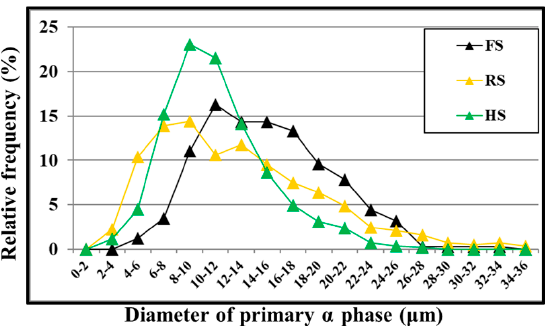
Figure 4. SEM fractographs of samples at maximum cyclic stresses of 600 MPa: ( a ) FS (N = 1.03569 × 10 5 cycles), ( b ) RS (7.28959 × 10 5 cycles), and ( c ) HS (1.128265 × 10 6 cycles).